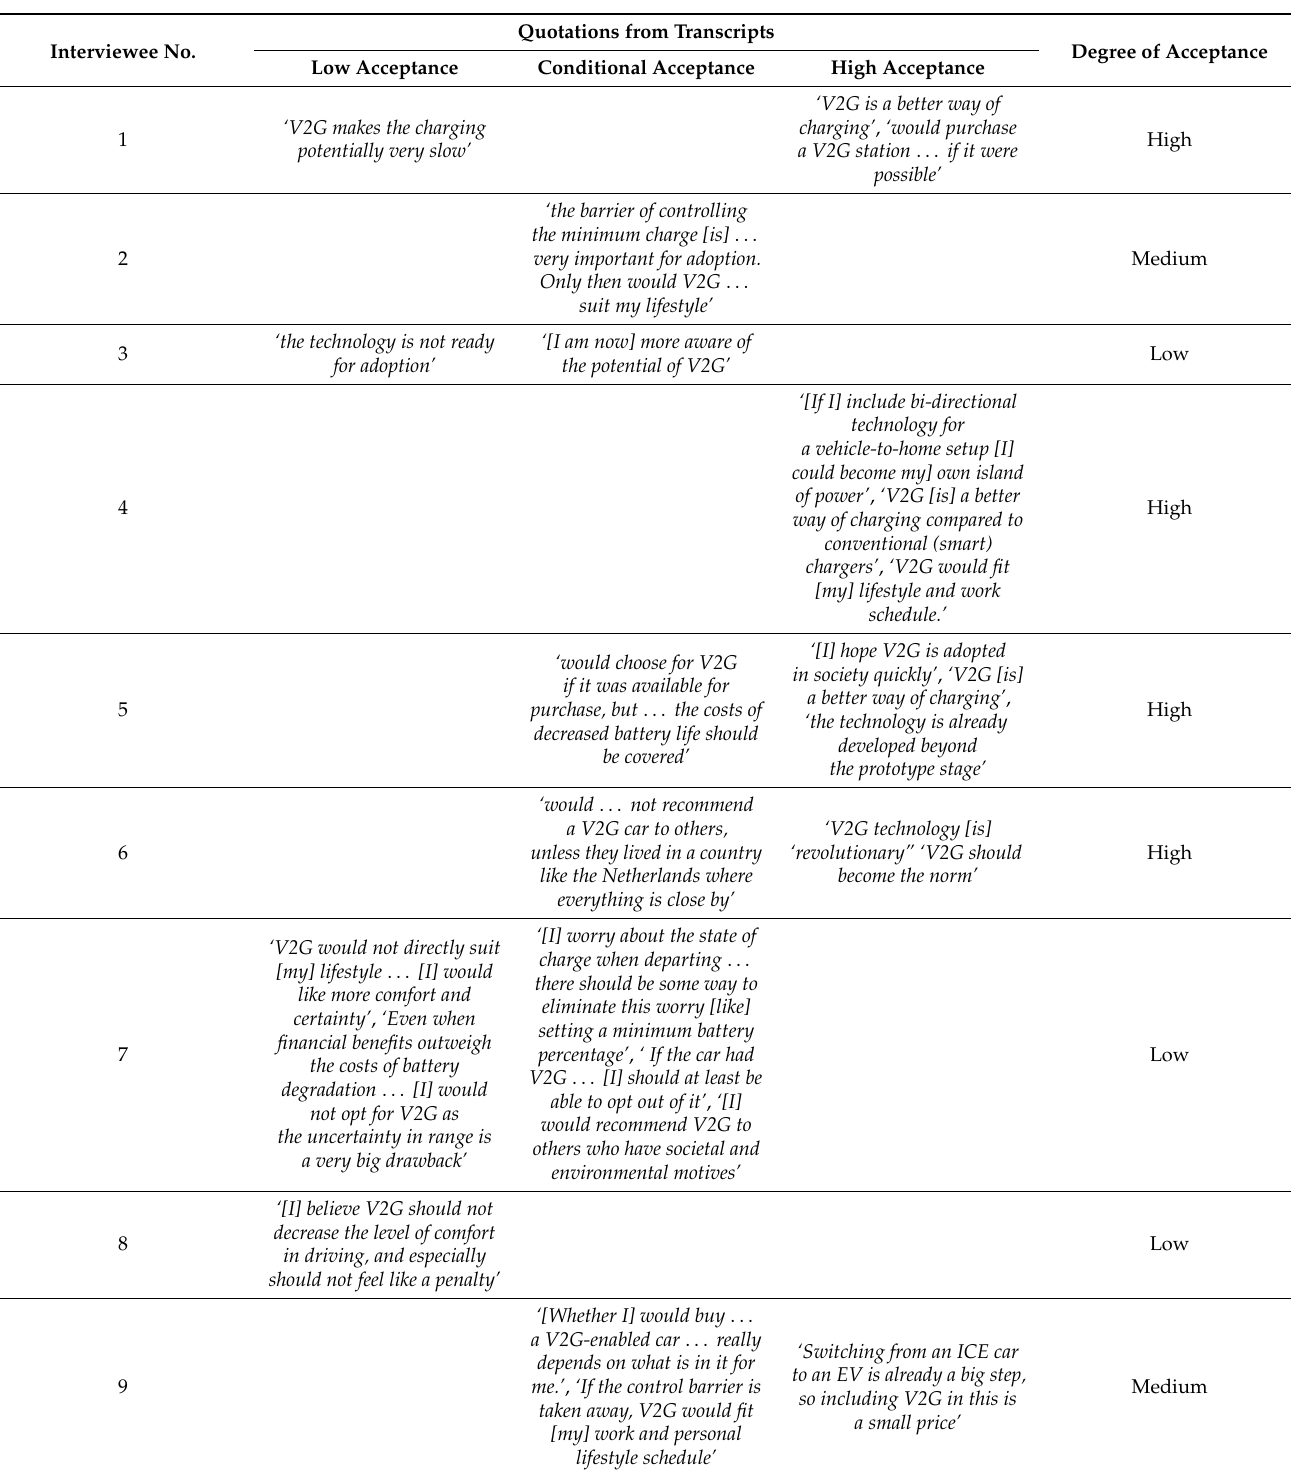
Table 2. Qualitative interpretation of consumer acceptance of V2G charging of interviewees in the